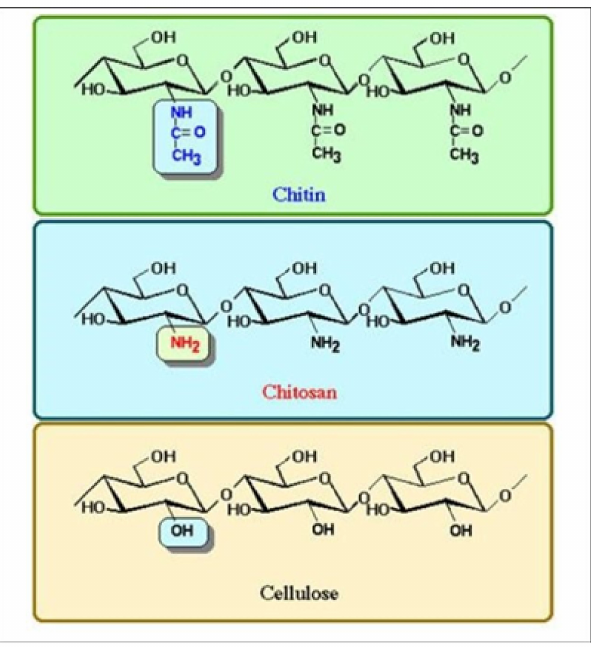
Figure 3. The different chemical groups characterizing cellulose from chitin and